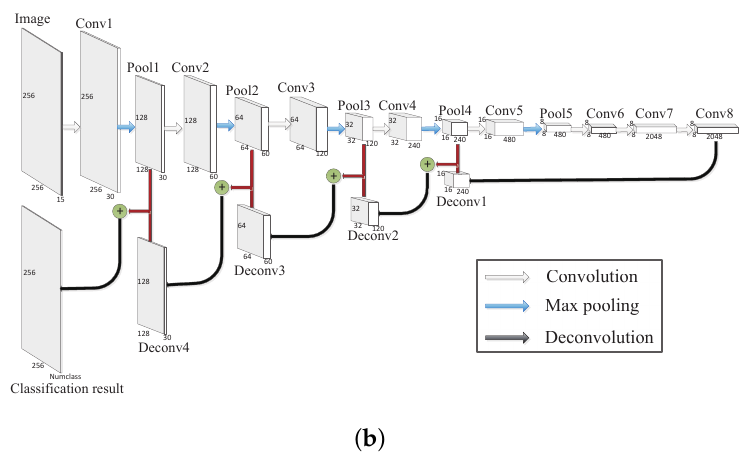
Figure 2. The architecture of SFCN, which is based on FCN [44]. The architectures of SFCN-128 and SFCN-256 are shown in ( a , b ), respectively, where Image represents the input image, Conv represents the convolutional layer, Pool represents the max pooling layer, Deconv represents the deconvolutional layer, three color (including white, blue and black) arrows represent the convolution, max pooling, and deconvolution operation, respectively, and “+” represents the add operation. In addition, the size of each layer is also given. ( a ) The architectures of SFCN-128; ( b ) The architectures of SFCN-256.